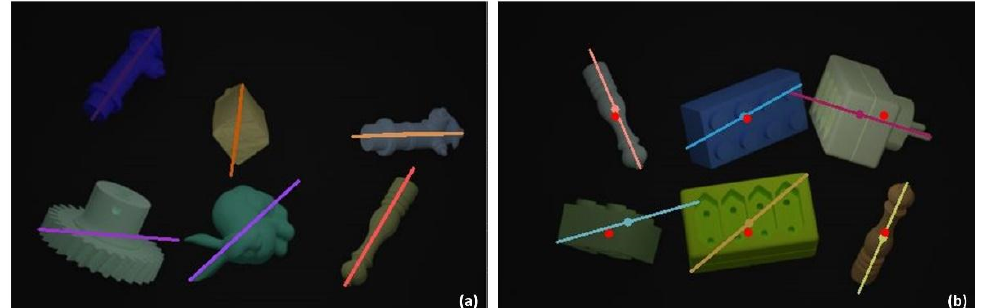
Figure 8. Pose estimation of the identified objects. ( a ) Approximated rotating axis of each object. ( b ) Actual (red) and estimated (colored) center points of each object.